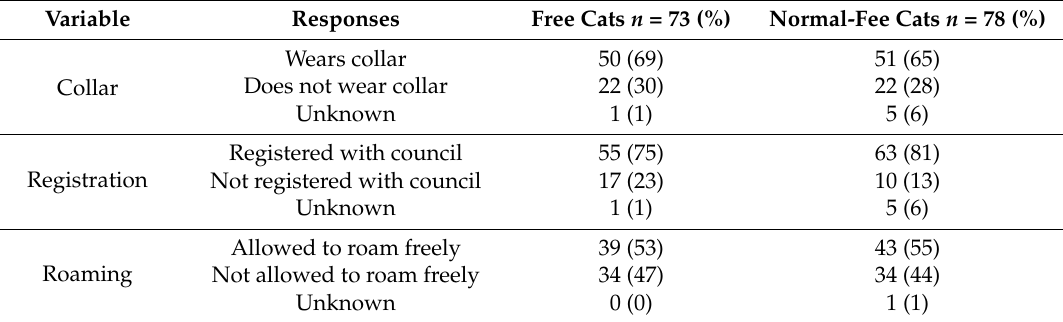
Table 5. Compliance of people adopting free and normal-fee cats with three variables of responsible cat ownership under WA legislation [25]. Wearing collars and registering cats with local councils are mandatory. Restricting cats to private property is